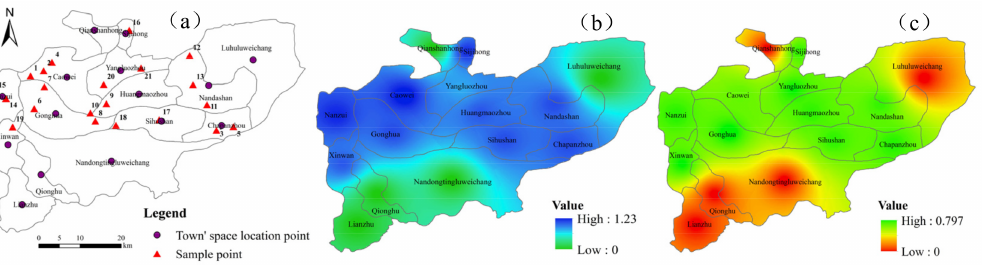
Figure 5. Spatial distribution of the correction coefficients according to the interpolation method: ( a ) town’ location point in space and sample point for the reliability test in space, ( b ) fertilization correction coefficient, and ( c ) comprehensive correction